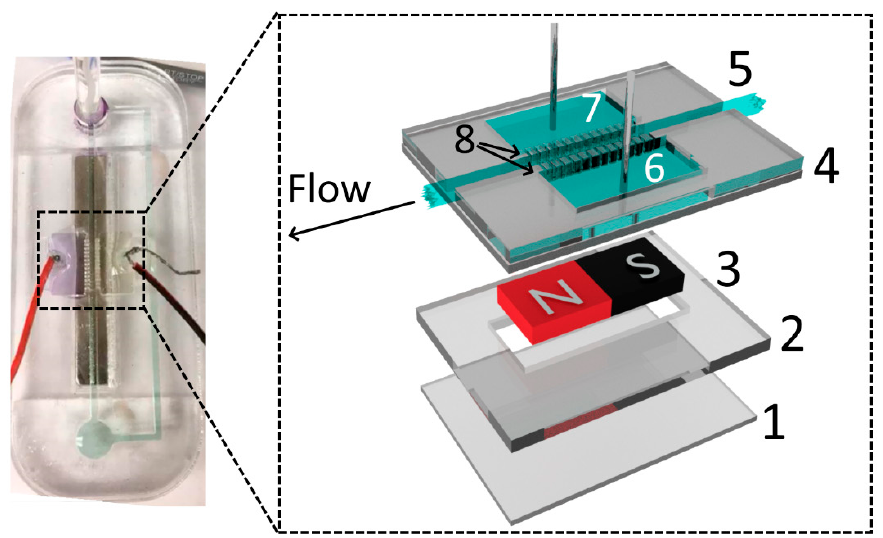
Figure 1. Picture of a single-pump magnetohydrodynamic (MHD) chip. Inset shows the schematic diagram of an MHD pump: ( 1 and 2 ) PMMA magnet holders, ( 3 ) N52 magnet, ( 4 ) PMMA chip, ( 5 ) main channel (1.53 mm width), ( 6 and 7 ) side bubble release reservoirs with electrodes, ( 8 ) grooves used to connect the electrolyte from the side reservoirs to the main channel.